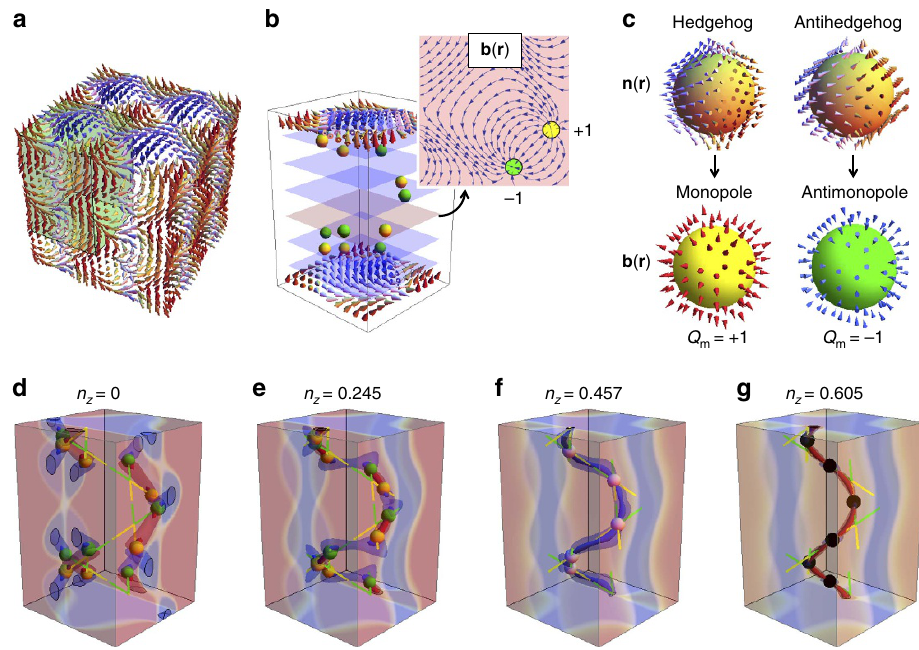
Figure 1 | Spin configuration and corresponding emergent magnetic field with monopole solution in MnGe. ( a ) Spin orientation in a 2 (cid:3) 2 (cid:3) 2 magnetic unit cell. ( b ) Configuration of emergent monopoles (yellow dots) and antimonopoles (green dots) in a 1 (cid:3) 1 (cid:3) 1.5 magnetic unit cell corresponding to the green box in a , displayed with constant z planes (blue and pink planes). A stream of emergent field between a monopole and an antimonopole on the same z level is also exemplified (pink plane). ( c ) Hedgehog and antihedgehog spin arrangements n ( r ) realized in the spin structure of MnGe, which are regarded as quantized source (monopole; Q m ¼ þ 1) and sink (antimonopole; Q m ¼ (cid:6) 1) of emergent field b ( r ), respectively, acting on conduction electrons. ( d – g ) Monopoles’ and antimonopoles’ positions and their trajectories (yellow and green dots and lines) and distributions of emergent magnetic field under varying magnetic field applied along the z direction. Monopoles and antimonopoles collide at white dots ( f ) and pair annihilate at black dots ( g ). Three contours of emergent-field distribution, that is, regions with | b z | ¼ 10 and 2, and surfaces of green box of a with | b z | o 0.1 are dyed according to strength and sign of b z —thicker colour for larger magnitude of b z , red and blue for positive and negative b z , respectively ( d – g